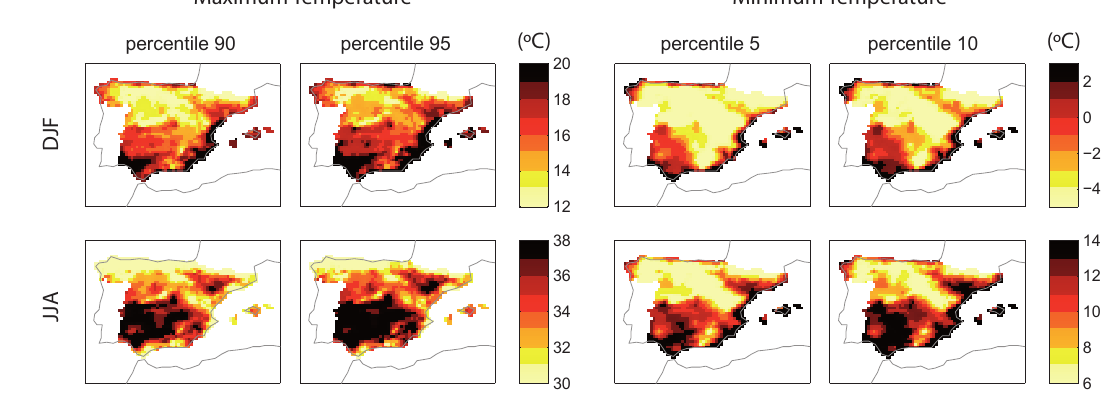
Fig. 1. Observed percentiles for maximum (90th and 95th) and minimum (5th and 10th) temperature in winter and summer according to the Spain02 data